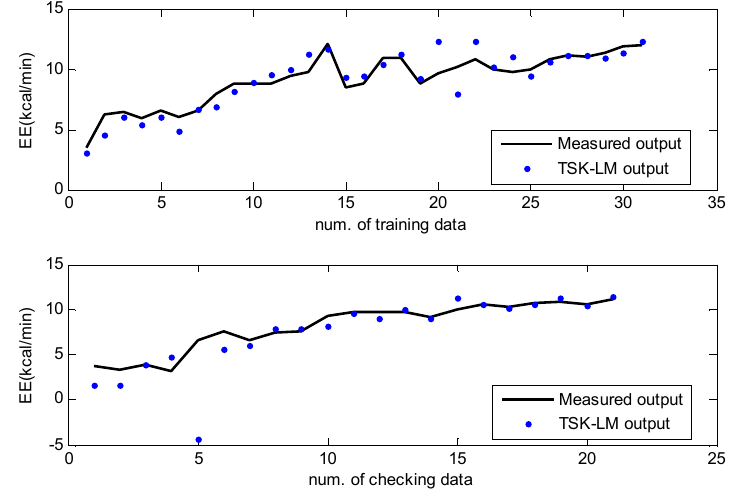
Figure 13. Approximation and generalization capability for slow running data.